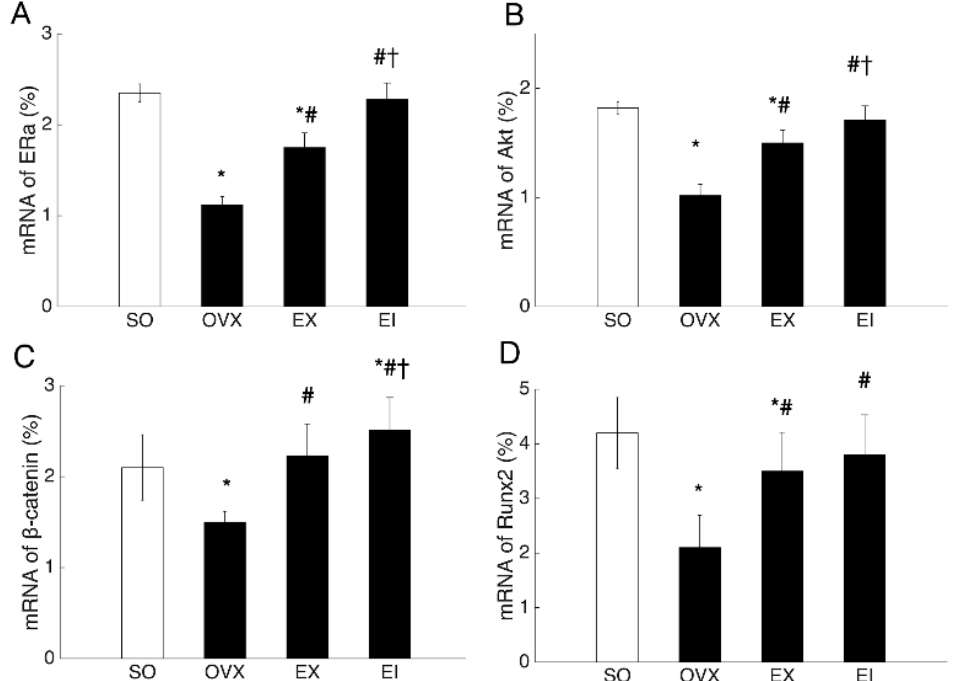
Figure 3. The percentage of ER α , Akt, β -catenin, and Runx2 mRNA in osteoblast culture. SO: Sham- operated; OVX: ovariectomized; EX: exercise; EI: exercise and Icariin. 1. Comparison of the groups of OVX, EX, and EI with SO group: * <0.05. 2. Comparison of EX and EI groups with OVX group: # <0.05. 3. Comparison between EX with EI group: † <0.05.